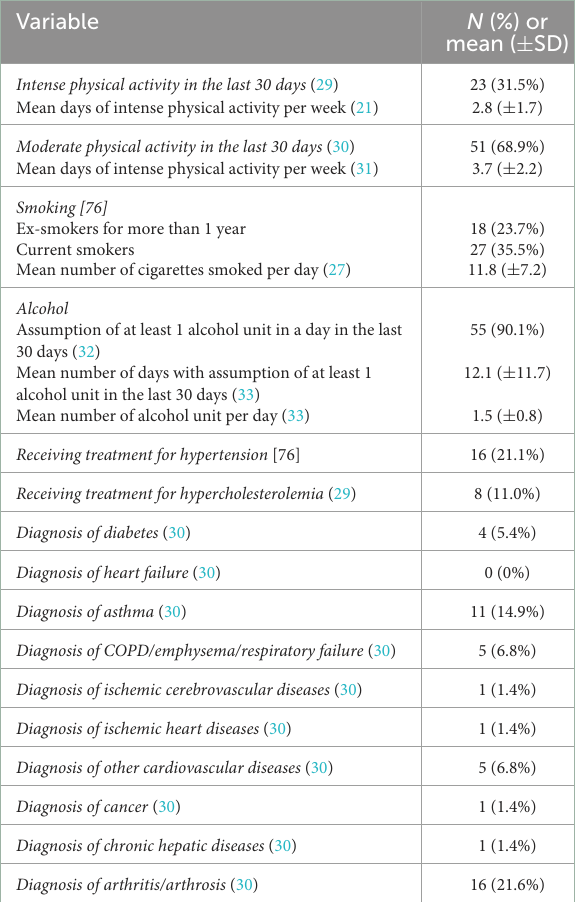
TABLE 1 Participants’ health status and risk factors (N responders).